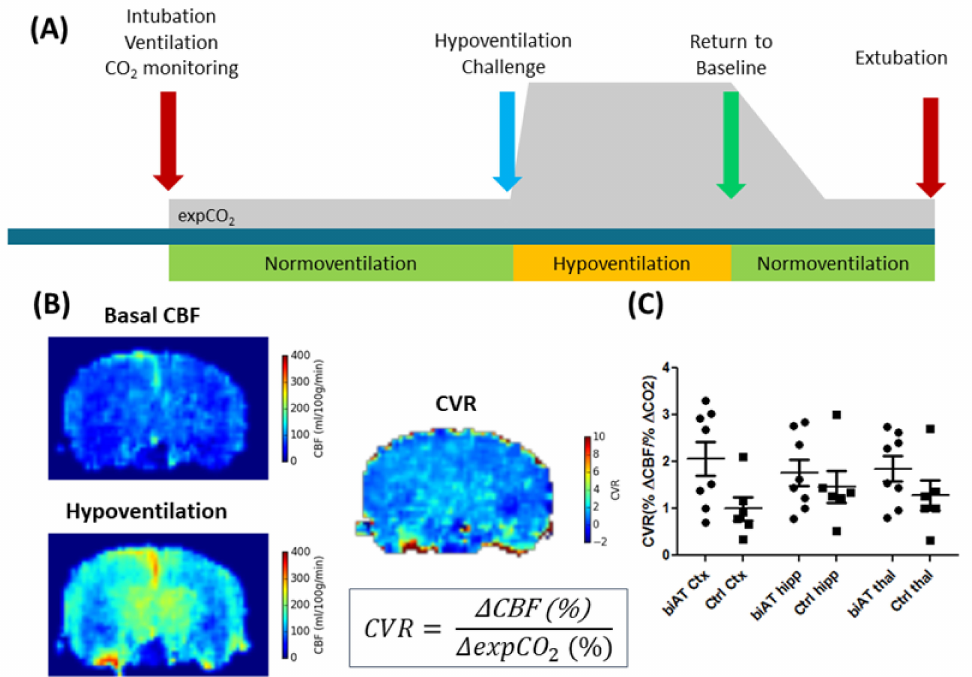
Figure 4. ALS experiments in control mice (Ctrl) and an Alzheimer disease model (biAT) according to [111]. ( A ) Illustration of the experimental paradigm. Animals were intubated, and ventilation was controlled. ALS measurements commenced during a period of normoventilation. In order to assess the cerebral vascular response (CVR) to a hypercapnic challenge, animals were hypoventilated. This was followed by a control measurement under normoventilation. Expired CO 2 levels (expCO2) were recorded during the experiments. More details on the protocol can be found in [111,114]. ( B ) CBF maps and calculation of the CVR based on the baseline CBF and the CBF acquired under hypoventilation. ( C ) Comparison of CVR in the cortex (Ctx), hippocampus (hipp) and thalamus (thal) of control mice and biAT mice. This figure is based on data presented in